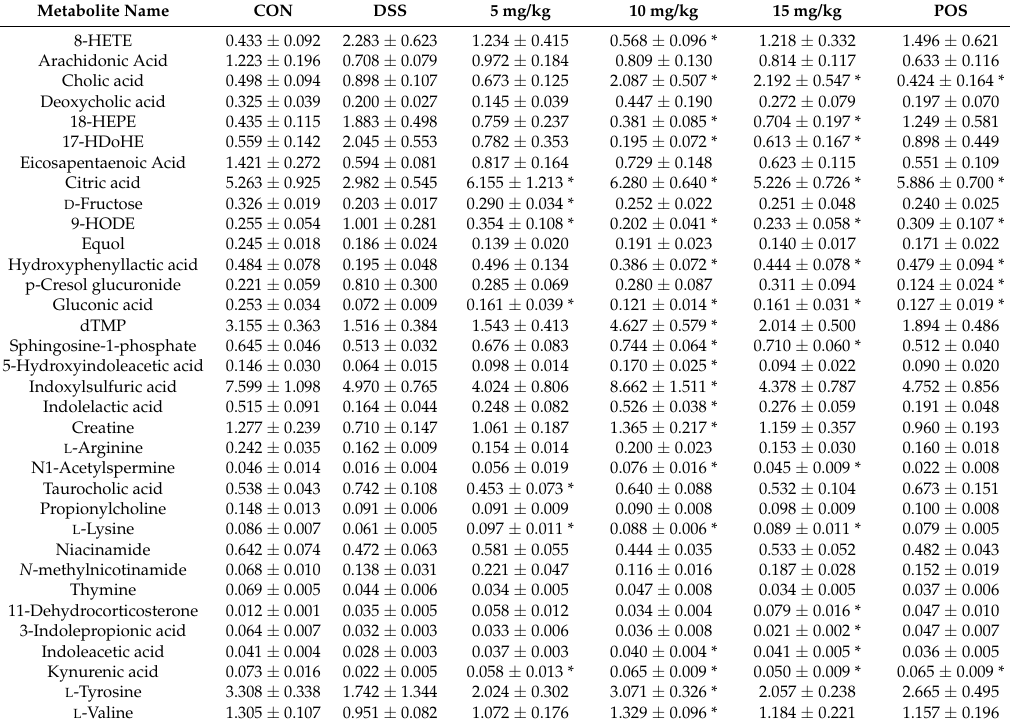
Table 2. Significant changes of metabolome in colon tissue of mice induced by